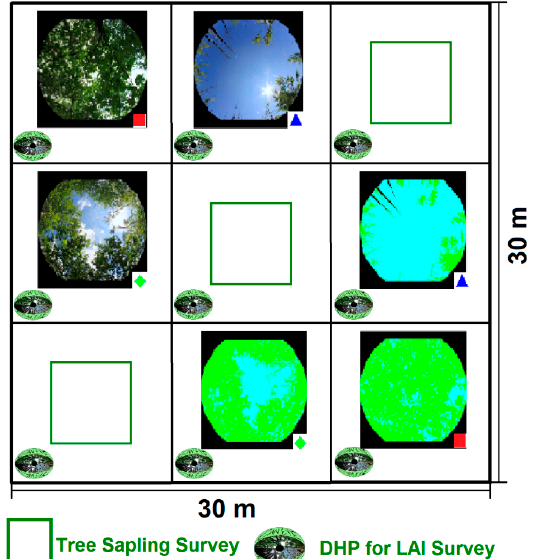
Figure 2. Layout of sampling plot. Three 5 m × 5 m quadrates are used for tree sapling abundance survey. Nine fish-eye photos were used for estimation of leaf area index. Three upward digital hemispherical photography (DHP, top-left) pictures show examples of in situ canopy measurement, while tree processed pictures (low-right) show corresponding classification results (see marks) in CAN-EYE software. The black areas in mid-right picture (blue triangle) represent masked dead standing stems in corresponding DHP picture (top-middle).